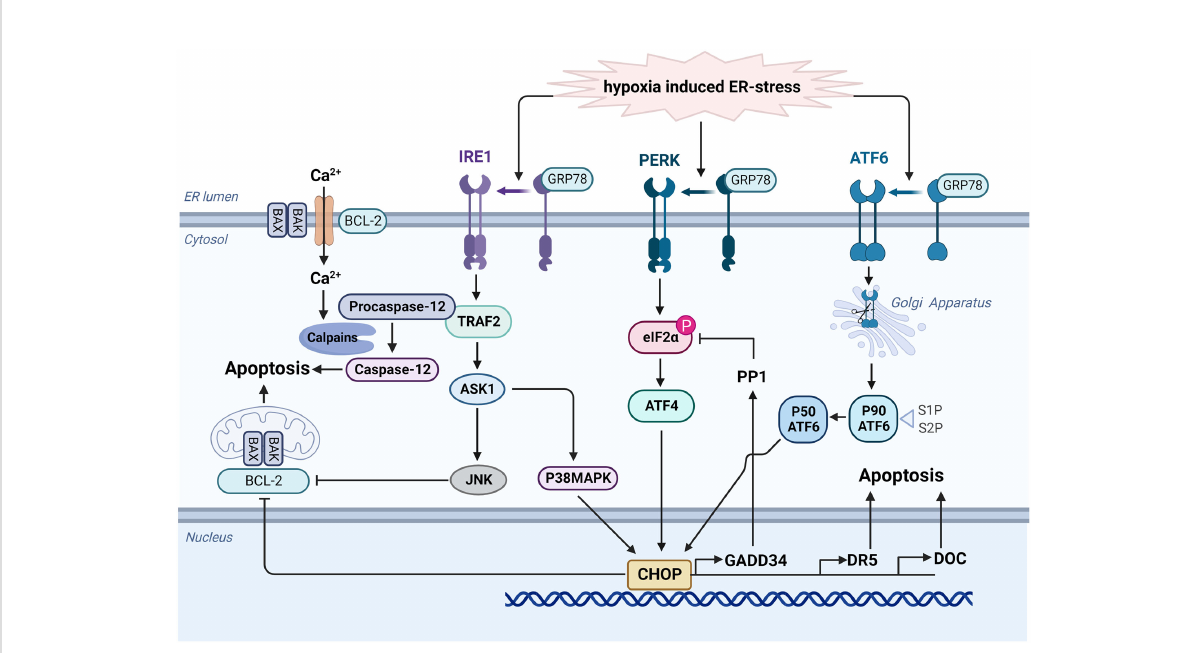
FIGURE 3 Hypoxia activates the UPR signaling network to mediate apoptosis. When ERS damage occurs, GRP78 dissociates from PERK, ATF6 and IRE1 a . Activated ATF6 can be transported to Golgi apparatus. After modi fi cation, it could induce CHOP expression and lead to UPR-related apoptosis via the inhibition of BCL-2 protein family and the activation of multiple genes including GADD34, DR5, and DOC. Similarly, activated PERK phosphorylates the a subunit of eIF2 and initiates translation of ATF4, then promoting the transcription of CHOP. Additionally, activated IRE1 a stimulates the expression of TRAF2, then activate ASK1 and JNK to promote apoptosis. TRAF2 also promotes clustering of procaspase-12, and it will be activated into caspase 12 by calpains under ER stress. Created with